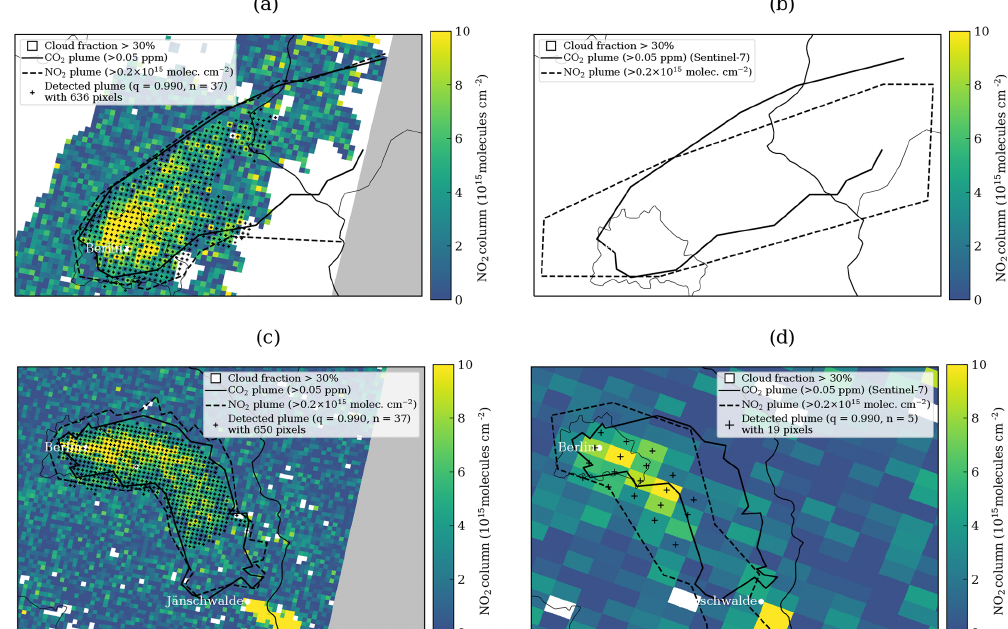
Figure 10. Examples of comparing plume detection between the (a, c) CO2M’s and (b, d) Sentinel-5’s NO 2 instruments. (a, b) Due to a time lag of 2h, the scene is cloudy during the Sentinel-5 overpass but not during the CO2M overpass (3 December 2015). (c, d) The plume position clearly changed between the two overpasses (17 June